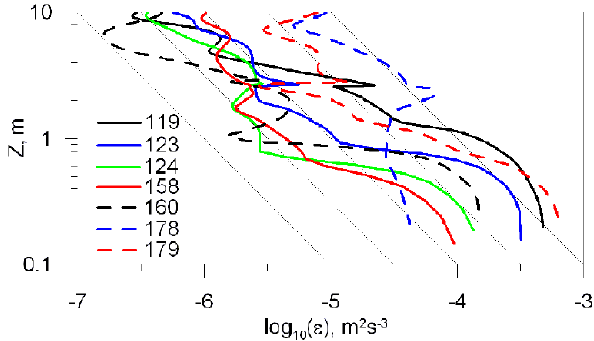
Fig. 8. A closeup of ε versus z in the near-bottom layer (the low- est 10m) for a number of stations when the microstructure sonde reached the sea floor. Numbers on the panel are the station numbers. Thin straight-line segments with a slope of − 1 are the theoretical curves given by Eq.